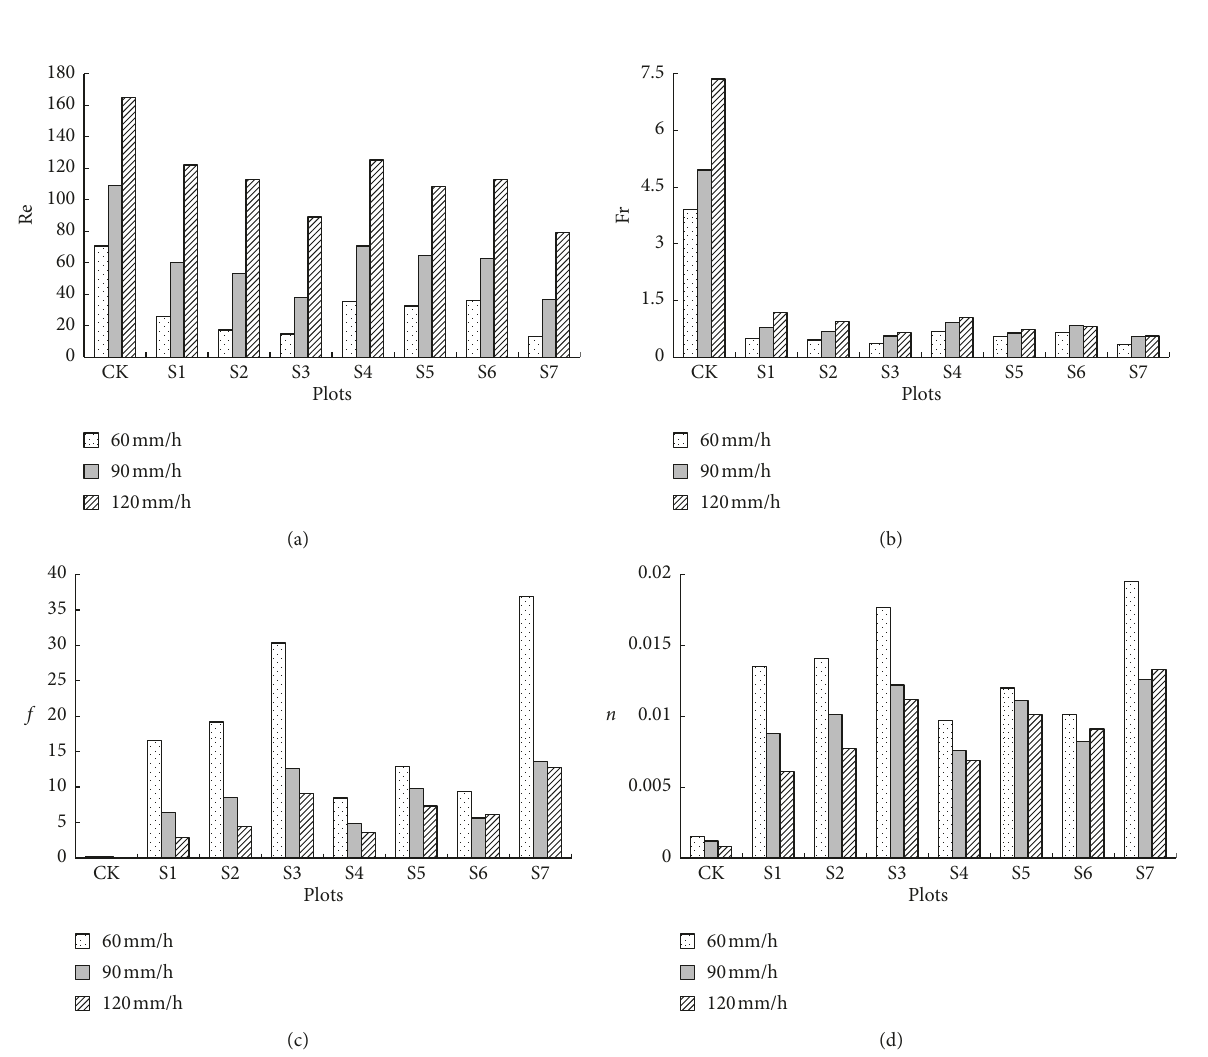
Figure 3: Runoff hydraulic characteristics under different vegetation covers and rainfall